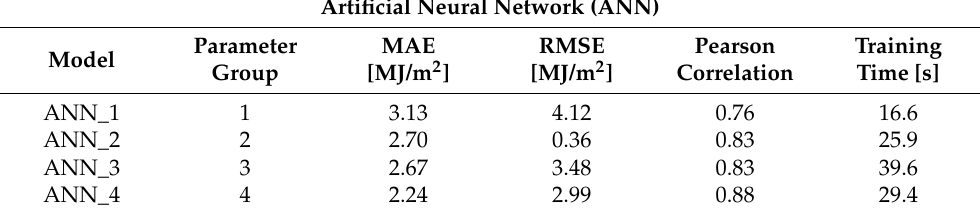
Table 5. ANN forecasting results for 5 neurons in the first hidden layer, 2 hidden layers, and 0.5 threshold.